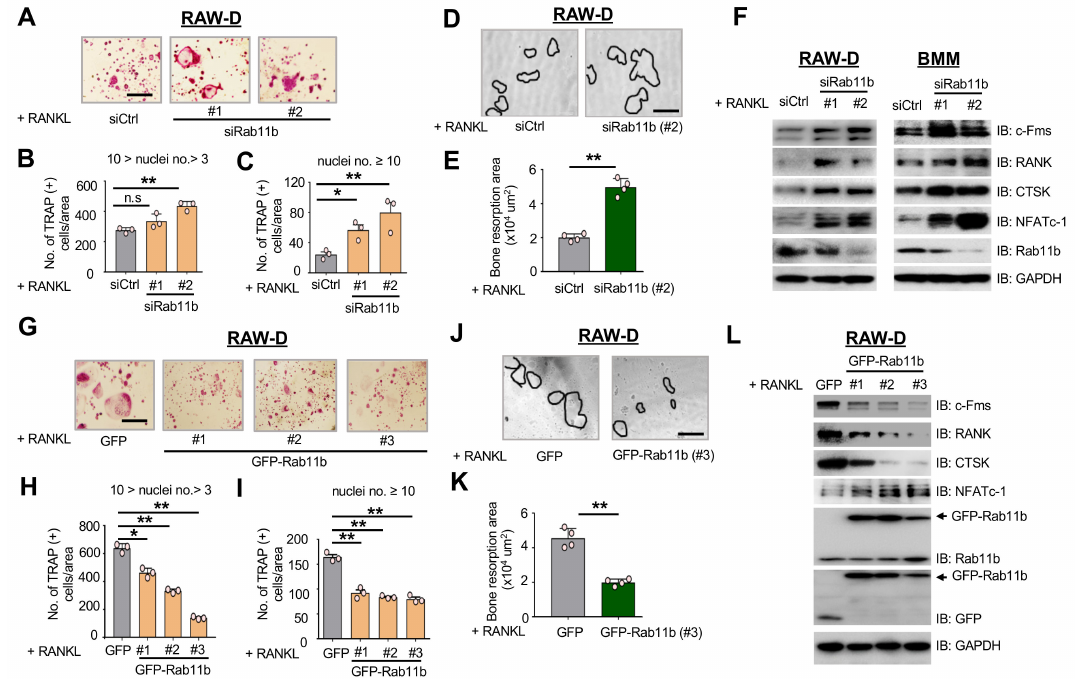
Figure 2. The e ff ects of Rab11b knockdown and overexpression on osteoclastogenesis. ( A ) RAW-D cells were transfected with 10 pmol non-targeting siRNA (siCtrl) or two di ff erent types of Rab11b-specific siRNA (siRab11b #1 and #2) for 24 h. Then, the cells were cultured for an additional 3 days with media containing RANKL (300 ng / mL). TRAP-staining was performed to evaluate osteoclast formation. Bars 200 µ m. ( B ) The number of TRAP-positive osteoclasts simultaneously having more than 3 nuclei and less than 10 nuclei per viewing field was counted. ** p < 0.01; n.s, nonsignificant (Student’s t -test); compared to the control. ( C ) The number of TRAP-positive osteoclasts having 10 or more nuclei per viewing field was counted. * p < 0.05; ** p < 0.01 (Student’s t -test); compared to the control. Mean ± SD of three independent repeats. ( D ) The images of the bone resorption area induced by RAW-D cell-derived osteoclasts transfected with siCtrl or siRab11b before seeded and cultured on the Osteo Assay StripWell upon RANKL (500 ng / mL) stimulation for 7 days. ( E ) The bone resorption area was measured and analyzed using Image J software. Mean ± SD of triplicate samples. ** p < 0.01 (Student’s t -test), n = 3. ( F ) After siRNA transfection for 24 h, RAW-D cells and BMMs were di ff erentiated into osteoclasts by being cultured with RANKL (300 ng / mL) and a combination of RANKL (300 ng / mL) + M-CSF (30 ng / mL), respectively, for an additional 72 h. The total expression levels of c-Fms, RANK, NFATc-1, CTSK, and Rab11b were evaluated by immunoblotting, and GAPDH was used as a loading control. ( F ) The shown data were representative from two independent repeats. ( G ) RAW-D cells were transfected with retrovirus vectors either encoding Green Fluorescent Protein (GFP) as control or three di ff erent clones of GFP-Rab11b (abbreviated by #1, #2, and #3). The cultured cells were incubated with RANKL (300 ng / mL) for 3 days, and subsequently subjected to TRAP-staining analysis to assess the osteoclast formation. Bars 200 µ m. ( H ) The number of TRAP-positive osteoclasts having simultaneously more than 3 and less than 10 nuclei was counted. Mean ± SD of three independent repeats. * p < 0.05, ** p < 0.01 (Student’s t -test); compared to the control. Bars 200 µ m. ( I ) The number of TRAP-positive osteoclasts having 10 or more nuclei per viewing field was counted. Mean ± SD of three independent repeats. ** p < 0.01. ( J ) The bone-resorbing activities of the RAW-D-derived osteoclasts expressing GFP or GFP-Rab11b (clone #3). The cells were seeded and cultured on the Osteo Assay Stripwell Plates upon RANKL (500 ng / mL) stimulation for 10 days. ( K ) The images of the bone-resorption area were measured and analyzed using Image J software. Mean ± SD of the triplicate repeats. ** p < 0.01 (Student’s t -test) for the indicated comparisons. ( L ) The total expression levels of c-Fms, RANK, NFATc-1, CTSK, and Rab11b were evaluated by immunoblotting, and GAPDH was used as a loading control. The shown data were the representative from three independent